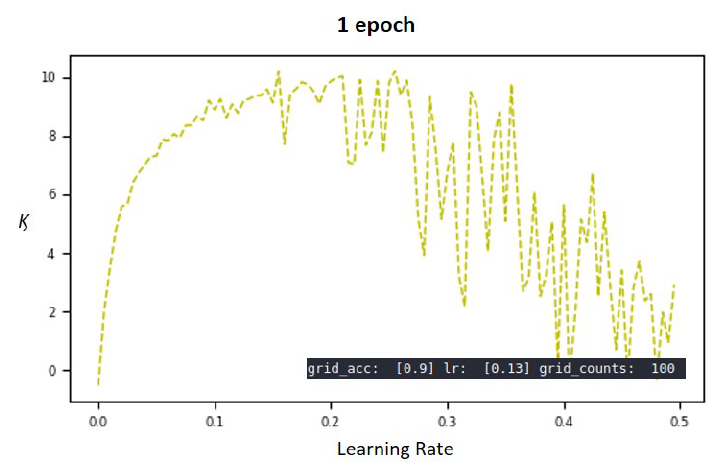
Figure 9. Estimation graph of objective function to MNIST model using κ